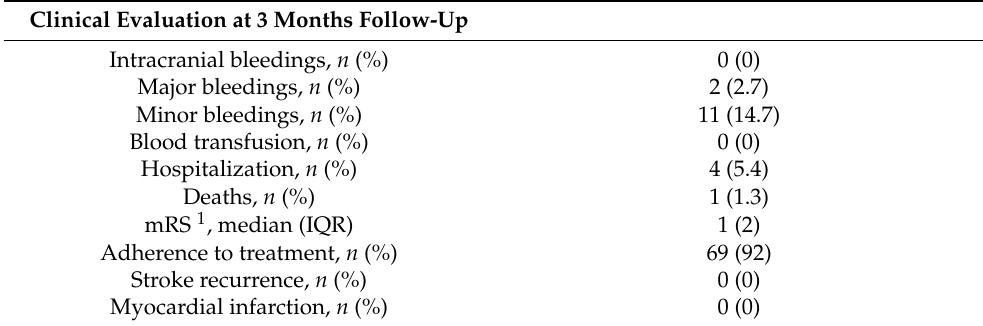
Adherence to treatment, n (%) 69 (92) Stroke recurrence, n (%) 0